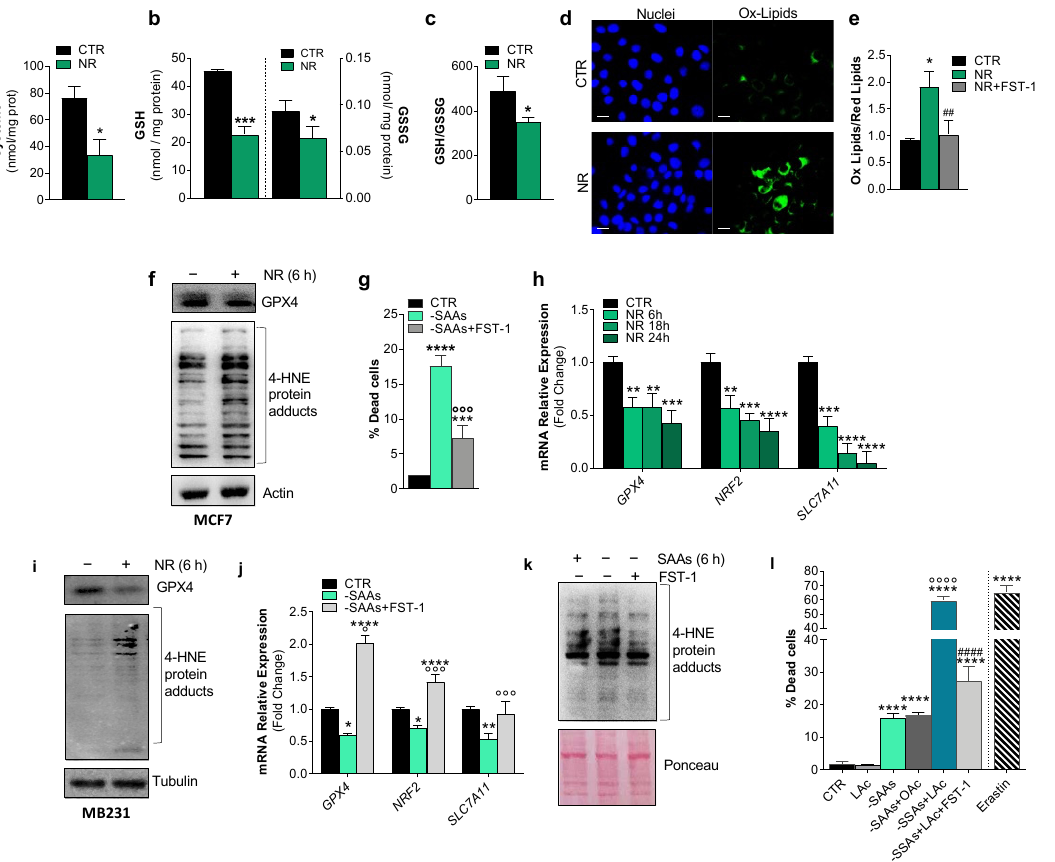
Figure 2. Nutrient restriction modulates typical ferroptotic hallmarks in breast cancer cells. ( a – c ) MCF7 cells were subject to nutrient restriction (NR: HBSS, 1 g/L glucose, 1% FBS) for 6 h. Intracellular cysteine ( a ), reduced (GSH) and oxidized (GSSG) glutathione ( b ) were measured by HPLC analysis and redox state was evaluated by calculating GSH/GSSG ration ( c ). ( d , e ) Lipid peroxides were determined by means of fluorescent microscopy ( d ) or cytofluorimetric ( e ) analysis after staining with the lipid oxidation sensitive probe C11-BODIPY 581/591. Scale bar: 20 μ m. ( f ) Western blot analysis of GPX4 and 4-HNE-protein adducts in MCF7 cells cultured under NR